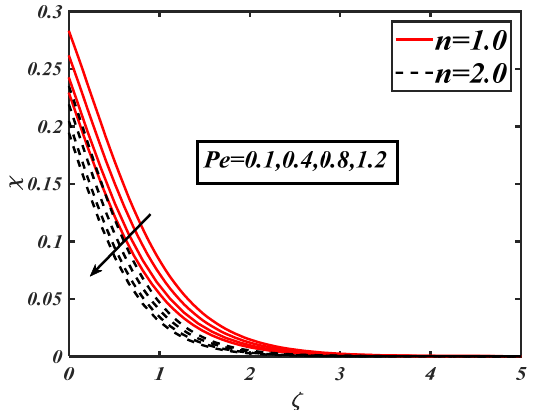
χ . Figure 21. Pe illustration against χ . χ .